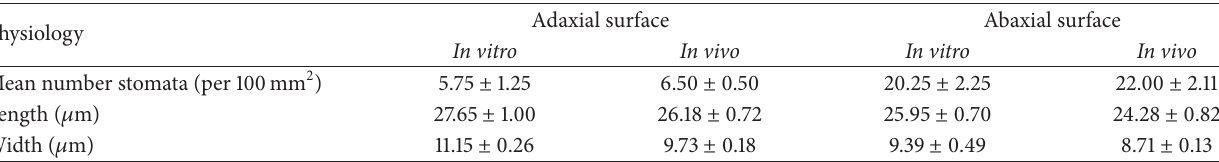
Table 9: Stomata morphology of in vitro and acclimatized ( in vivo ) plantlets of yellow C. crotalifera (CCY) under scanning electron